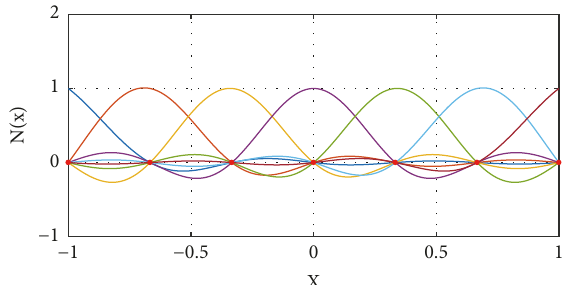
Figure 1: Kriging shape functions using 𝜎 = √(𝑥 𝑖+1 − 𝑥 𝑖 ) 2 for 7 control points uniformly distributed along the 1D domain.